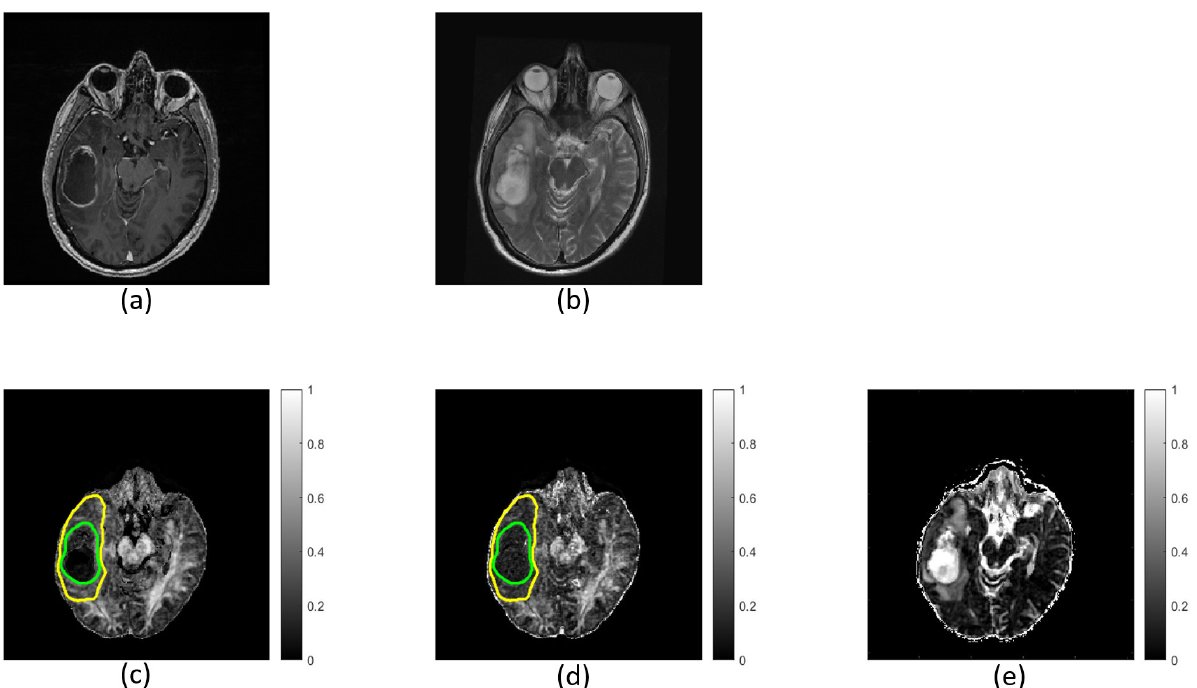
Figure 5. Images and maps from a grade IV patient: ( a ) T 1 w image; ( b ) T 2 w image; ( c ) free ‐ water (FW) ‐ corrected fractional anisotropy ( FAt ) map; ( d ) non ‐ corrected fractional anisotropy ( FA ) map with contours defining non ‐ enhancing tumor; and ( e ) FW map. Within the non ‐ enhancing region, more heterogeneity is revealed in the FAt map compared to the FA map. The FW map quantitatively highlights FW content.